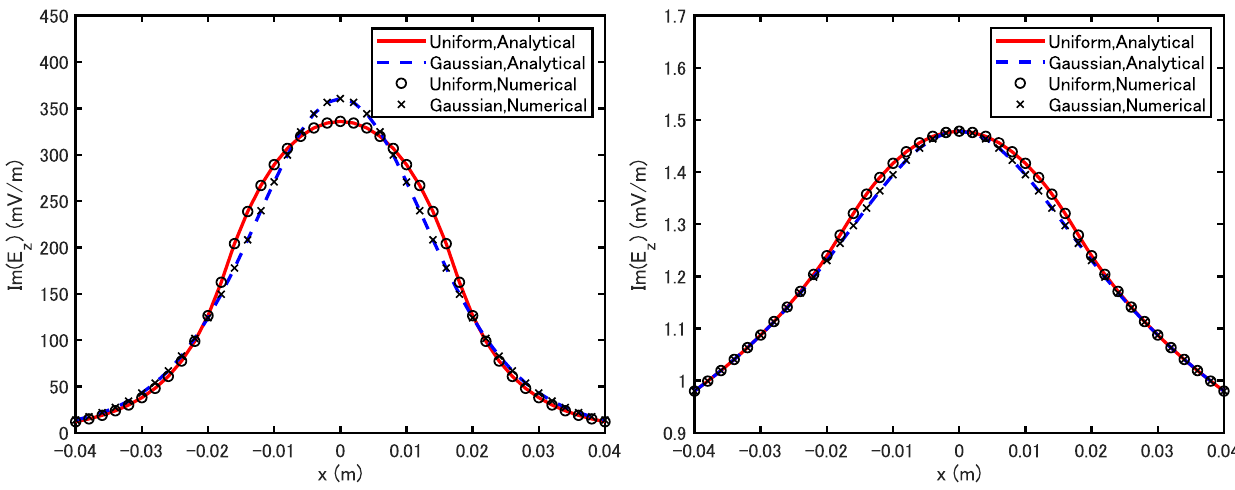
FIG. 3. Comparison of direct space charge fields of a round relativistic beam of total charge Q ¼ 1 pC with a transversally Gaussian charge density with half-width σ r ¼ 1 cm and of uniform charge density with radius r b ¼ 1 . 747 cm at y ¼ 0 and f ¼ 10 GHz. The results are obtained with the analytical solutions [44,47] and the volume integral (60) for the corresponding charge densities. Left: = γ ≈ 1 . 0 . Right: β ¼ 0 . 999 95 and k σ = γ ≈ 2 . 1 × 10 − 2 β ¼ 0 . 9 and k σ r r